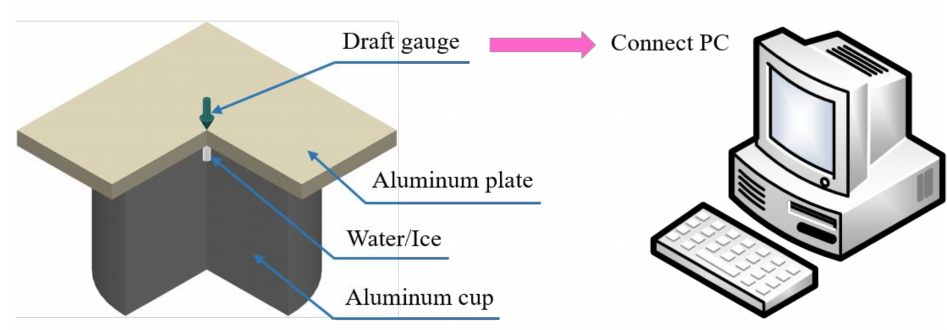
Figure 2. Swelling force test device.